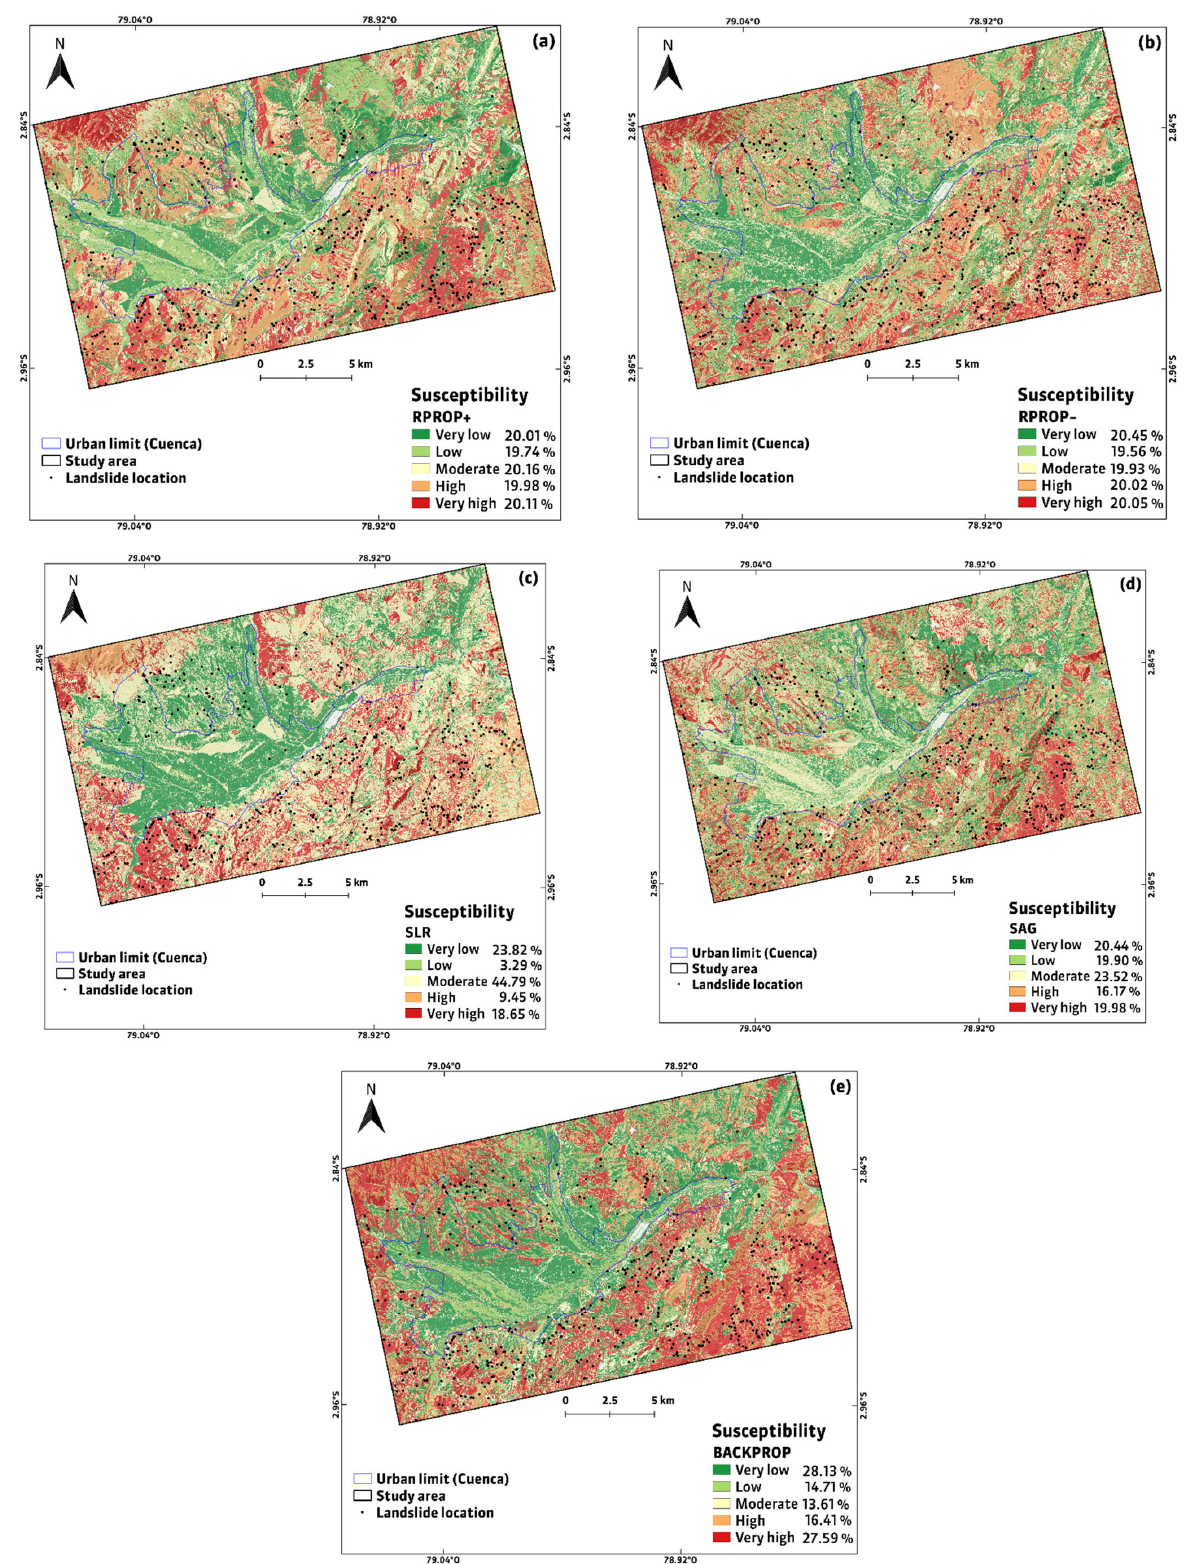
Figure 8. Landslide susceptibility maps obtained with each algorithm: ( a ) RPROP+, ( b ) RPROP − , ( c ) SLR, ( d ) SAG, and ( e )